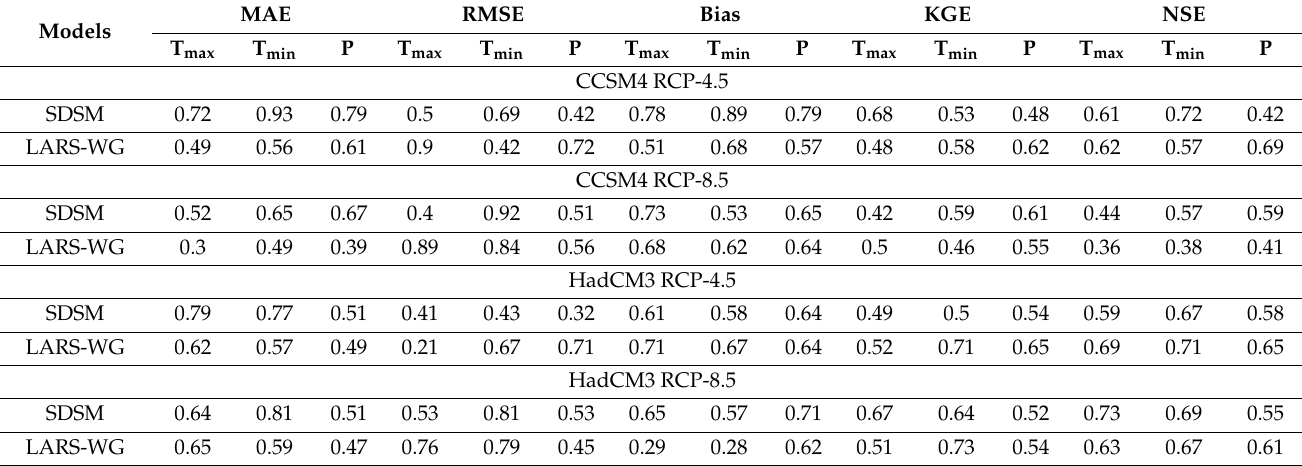
Table 8. Performance of the models during the validation period (2006–2020).